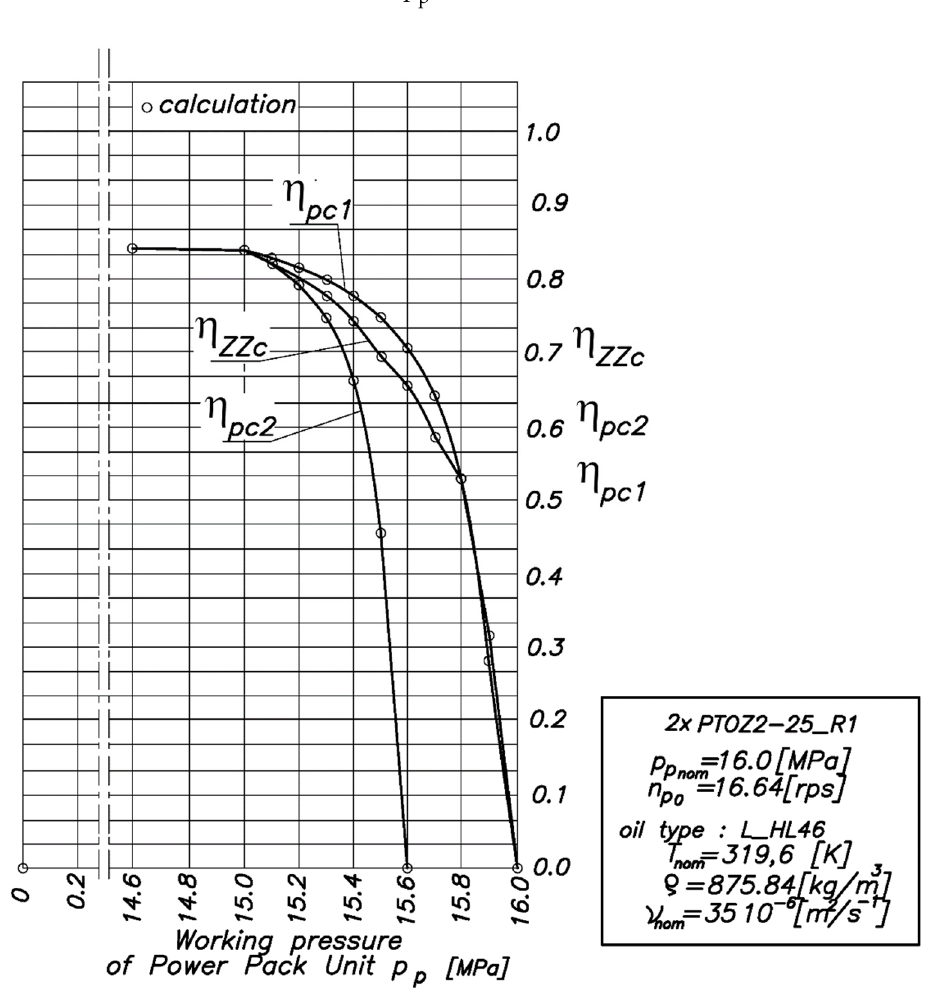
Figure 6. Results of numerical calculations of the dependence of the total efficiency of a twin-two- pump power pack unit, operating in an open system, consisting of two pumps of the PTOZ2-25-R1 type, with assumed linear characteristics of the pump constant-pressure regulators in the function of the power pack unit working pressure ratio p p . Source: own